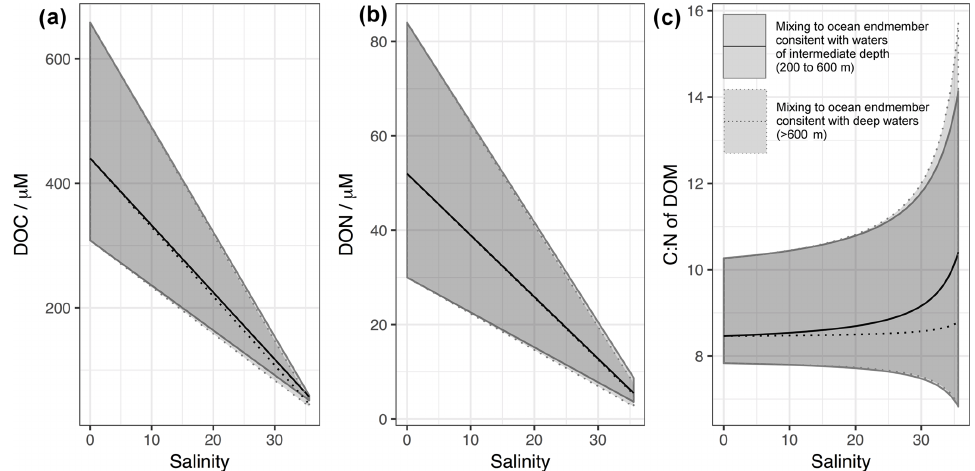
Figure 1. Predicted variation in (a) DOC, (b) DON and (c) C : N ratio of DOM with salinity based on literature values of observed endmember concentration ranges for North Sea and Baltic rivers and the open Atlantic adjacent to the NW European shelf. Data and originating studies detailed in Tables S1 and S2. Two ocean endmember ranges are presented, one for intermediate waters (200–600m) and one for deep waters ( > 600m). The C : N values presented here are intended to demonstrate the likely trend with salinity. C : N ratios of DOM presented represent only a subset of all possible values: upper (lower) estimates of DOC are divided by upper (lower) estimates of DON to give upper (lower) estimates of C : N. Including C : N rations predicted by upper DOC divided by lower DON and vice versa gives an unrealistically wide range of values.